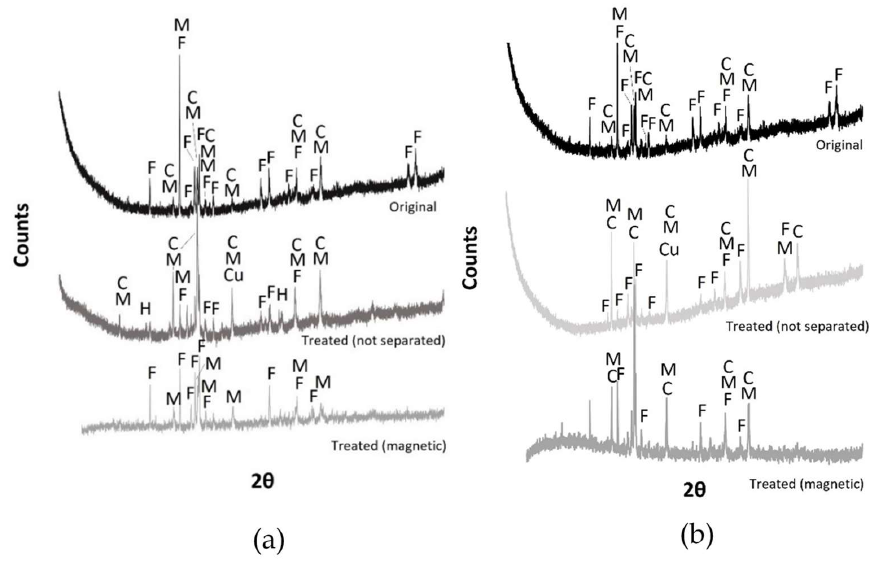
Figure 10. ( a ) Specimen Cubonus (C, CuFe 2 O 4 ; F, Fe 2 SiO 4 ; M, Fe 3 O 4 and all the iron spinel; Cu, metallic copper). ( b ) Specimen CuSin1 (C, CuFe 2 O 4 ; F, Fe 2 SiO 4 ; M, Fe 3 O 4 and all the iron spinel; Cu, metallic copper).